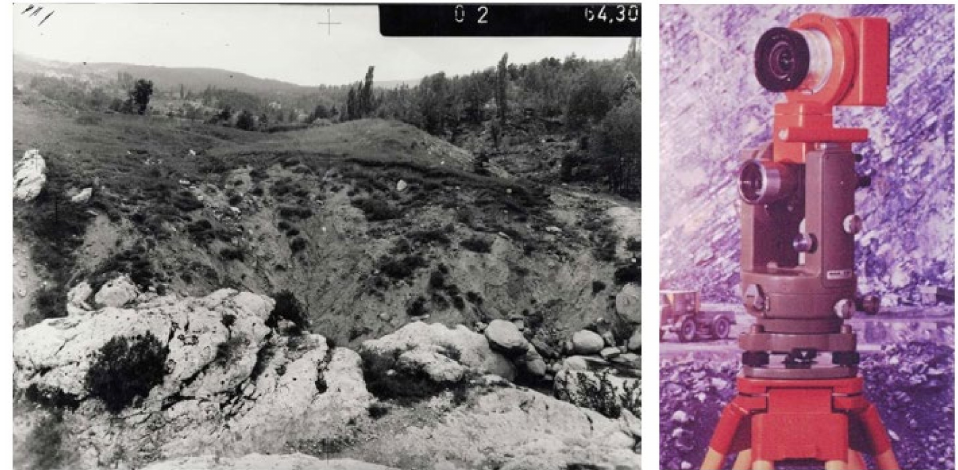
Figure 4. Left : example of a 6 × 8 cm glass plate photogram of landslide toe taken from the Vallcebre Torrent. Right : Wild P32 camera for terrestrial photogrammetry over a theodolite, which was used for the landslide toe monitoring between 1987 and